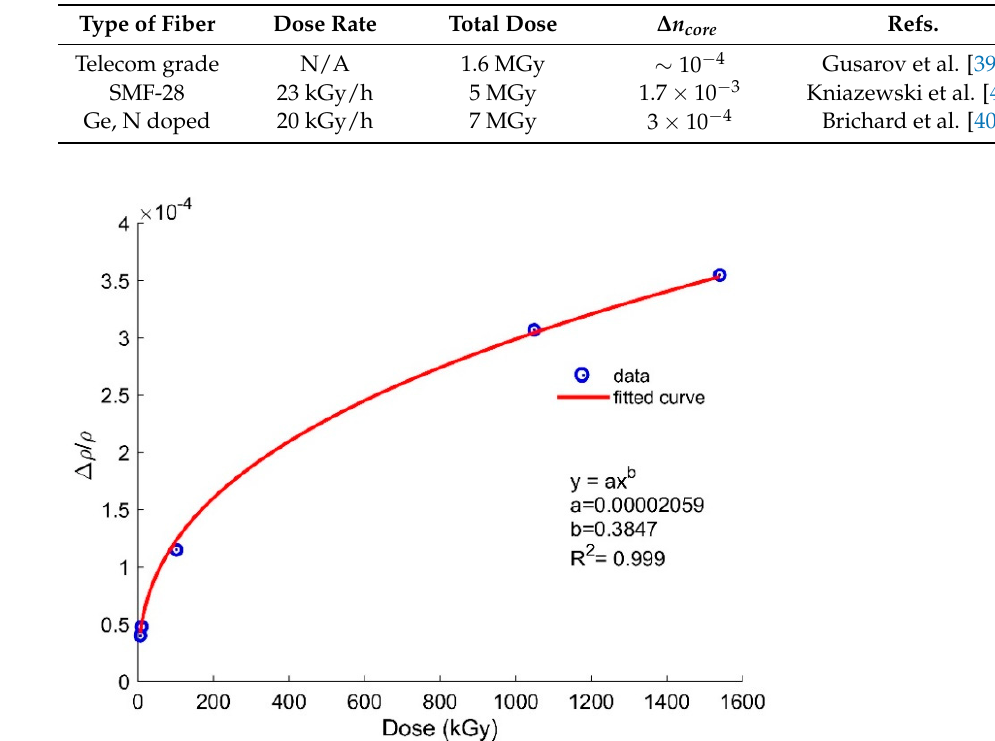
Table 3. Gamma-radiation-induced RI change in different compositional fibers at MGy dose.